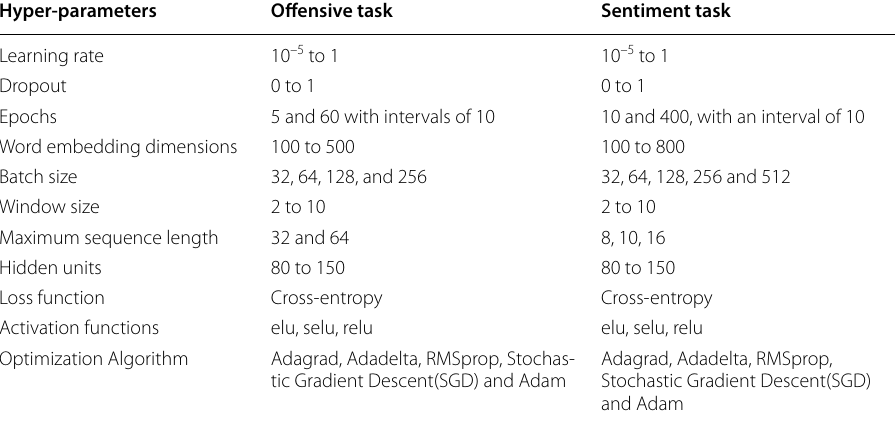
Table 4 Range of hyper-parameter values for deep learning models